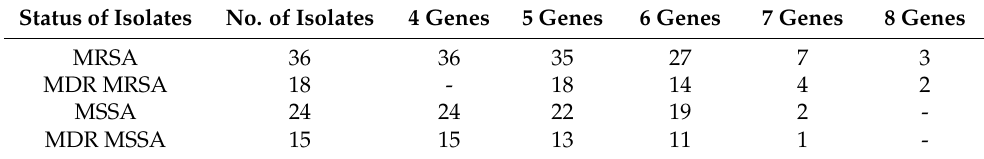
Table 3. Cumulative frequency of different combinations of efflux pump genes in different clinical isolates.